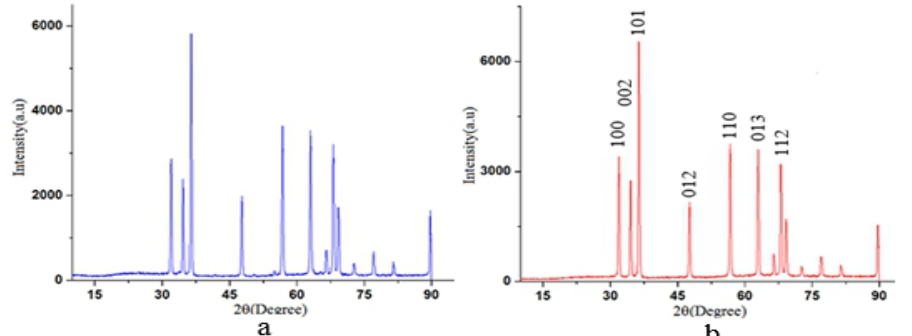
Fig. 3. XRD images of nanoparticles: a) 1.0% molybdenum doped ZnO and b) undoped ZnO